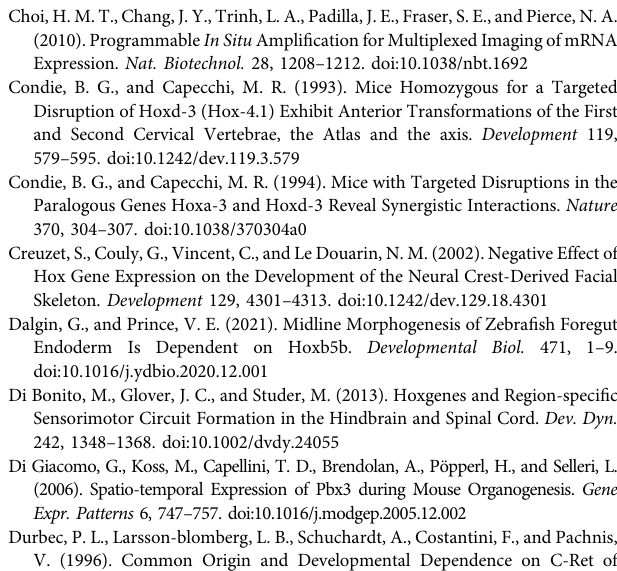
the hindbrain exhibit coincidence of all three probes along the Hindbrain (Hb), Pharyngeal (Pa), and PODs (arrowheads). Kaede + cells which are negative for both mRNA and protein are detected at the dorsal most aspect of the motor neuron complex (star) as well as in anterior regions of the presumptive CNS. (C) Images highlighting the midgut axis reveals a perfect coincidence of all three enteric labels with very littlebackground, demonstratingthe ef fi cacyof thePhox2b antibody as an enteric neural crest label. While nearly every cell is coincident, selected cells are annotated to aid in comparison (arrowheads). Scale bar A: 100 μ m. Supplementary Figure S2 | Characterization of novel hsp70l:GFP-hoxb5b transgenic zebra fi sh line. (A) GFP-Hoxb5b + overexpressing embryos at 24 hpf are easily distinguishable from GFP − siblings 1 hour after heat shock. GFP − and GFP + embryos are cultured and assayed under identical conditions to control for variations induced by growth at an elevated temperature. (B – C) GFP-Hoxb5b construct is localized to cell nuclei following heat shock and persists at least a day after initial induction (C) . Scale bar B: 100 μ M. Supplementary Figure S3 | Depletion of NCC-derived cells in the gut is not the result of cell death. (A – H) Wholemount IHC embryos stained with an antibody againstactivatedCaspase-3,amarkerforapoptoticcells.NCCsarevisualizedeither in the sox10:GFP or WT backgrounds in either uninjected or 15 pg vp16-hoxb5b injected embryos. Caspase-3 + cells are very rare along the length of the vagal domaininallcontrolembryosrangingfrom33 hpfto66 hpf(A,C,E,G).Whilediscrete pockets of Caspase-3 + cells are detected proximal to the POD NCC niche at 33 hpf (B) and 55 hpf (D) , very few co-positive cells are present at these time frames. Later in development at 63 – 66 hpf (F,H) almost no Caspase-3 + cells remain along the posterior aspect of the embryo, with only ectopic labeling of the somatic myotome detectable. Supplementary Figure S4 | Vagal NCC derivatives following Hoxb5b overexpression are largely unaffected. (A – D) Investigation of distinct NCC derived pigment lineages, melanophores (red arrowheads) and iridophores (yellow arrowheads), in 5 dpf embryos overexpressing Hoxb5b compared to controls. (E,F) Both control embryos and Hoxb5b overexpressing embryos by 50 hpf produced phenotypically wild type anterior dorsal root ganglia (DRG), as shown in whole mount immunolabeling with an antibody against Elavl3/4. (G,H) Position and development of the Superior Cervical Ganglion (SCG) occurs by the third day, as shown by immuno labeling for Elavl3/4 (red arrowhead). (I) Quanti fi cations from animals in Figure 5 , showing the number of Phox2b + cells localized along the gut length, excluding the POD increases in response to vp16- hoxb5b mRNA induction (I, 15 pg: p (cid:1) 9.92 × 10 – 5 ; 30 pg: p (cid:1) 0.000404). (J) The distribution of Phox2b + cells between the POD and the length of the gut was unchangedfollowingelevatedHoxb5bactivity[ (J) ,15 pginPOD: p (cid:1) 0.2515;30 pg in POD: p (cid:1) 0.3673;15 pg in Gut: p (cid:1) 0.2306; 30 pg inGut: p (cid:1) 0.3496]. ScaleBars (E,F,G,H) : 50 μ